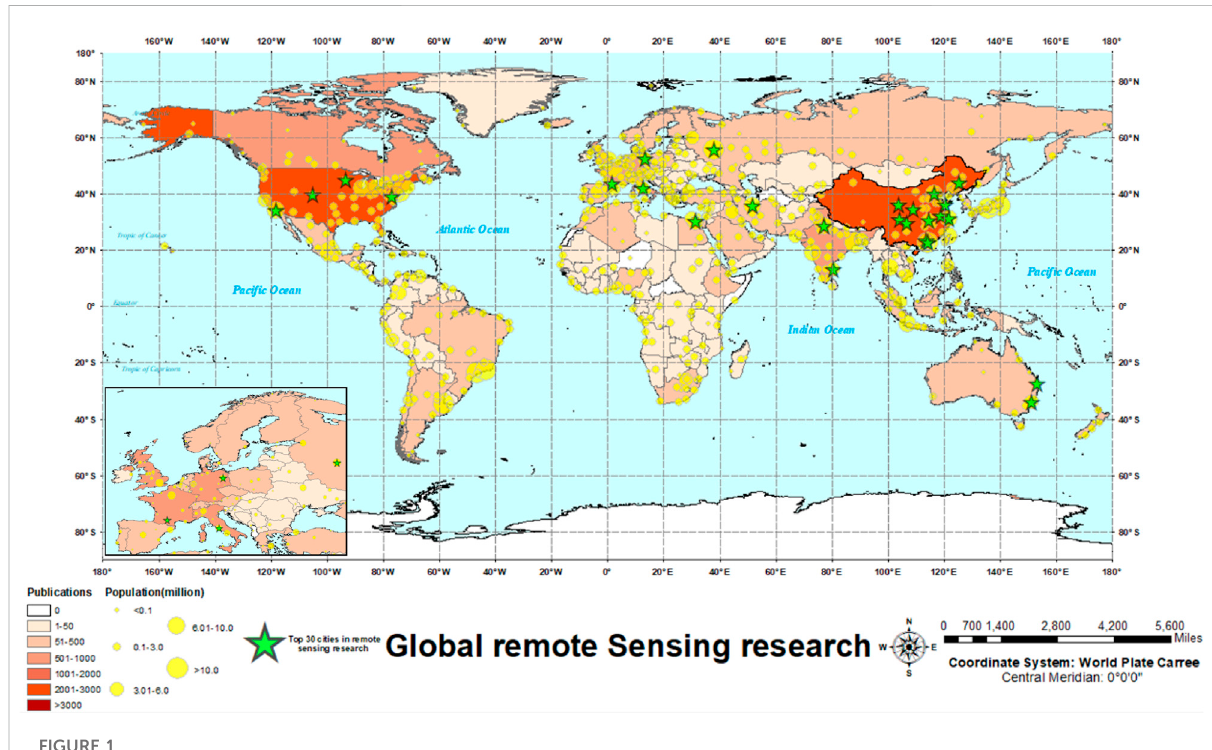
FIGURE 1 Geographic distribution of the global remote sensing research paper